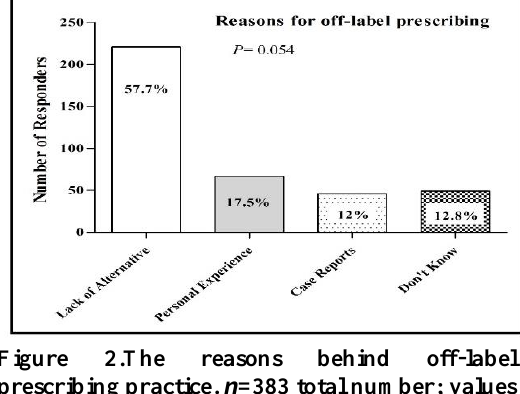
Figure 2.The reasons behind